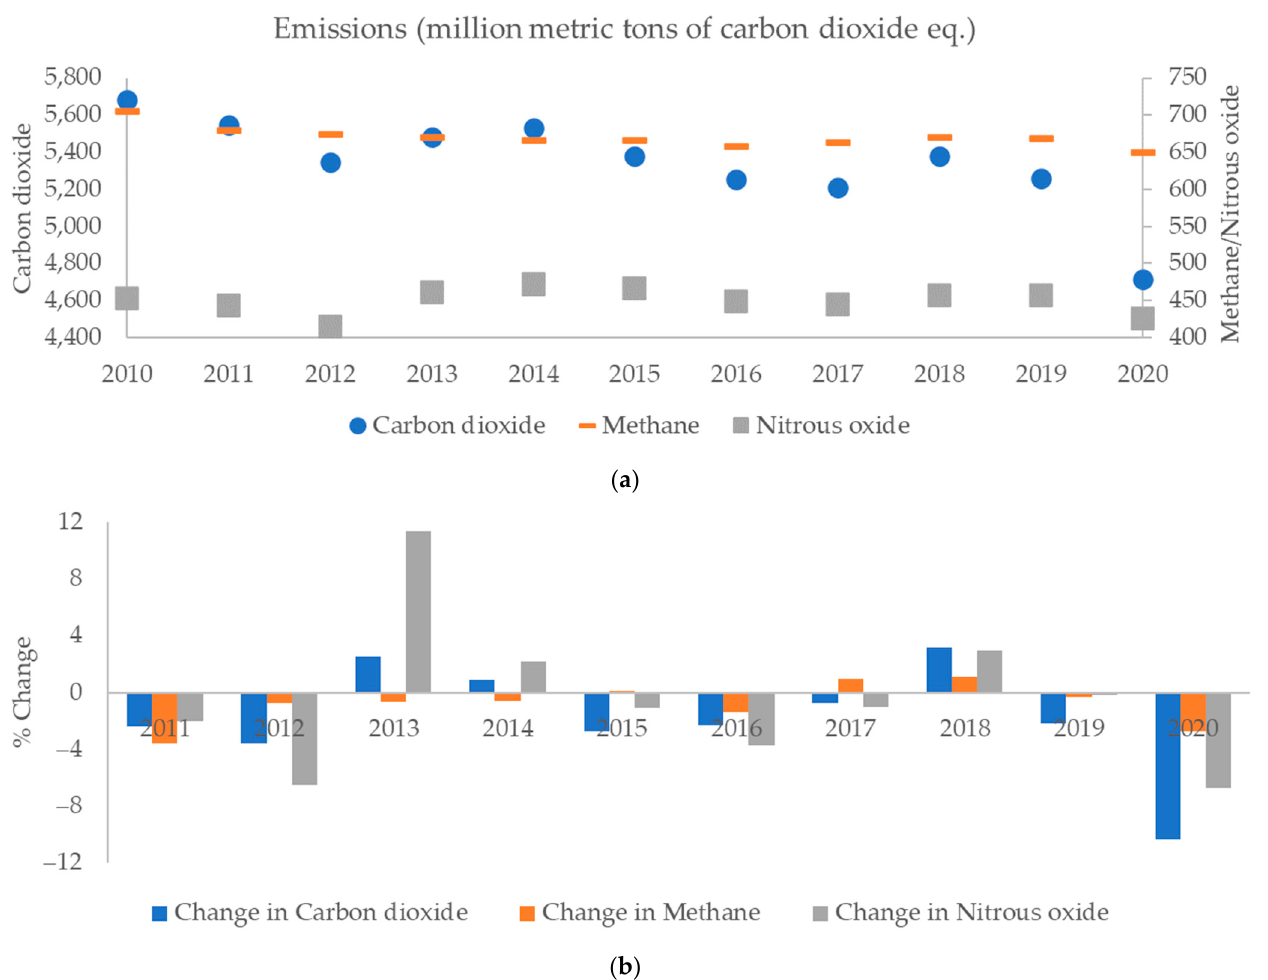
Figure 14. US greenhouse gas emissions 2010–2020: ( a ) total; ( b ) change